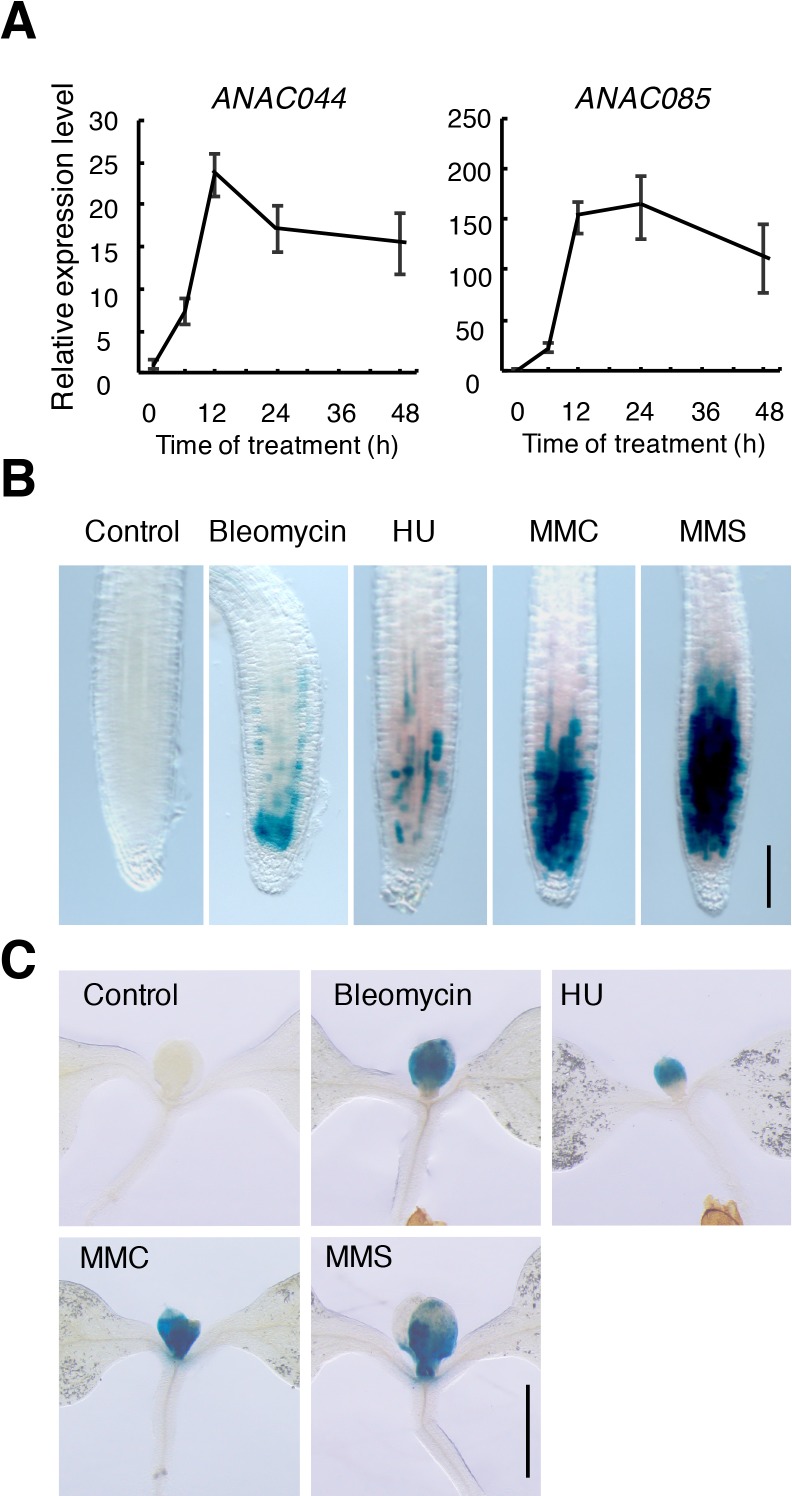
ANAC044 and ANAC085 are induced by DNA damage.(A) Transcript levels of ANAC044 and ANAC085 after bleomycin treatment. Five-day-old WT seedlings were treated with 0.6 µg/ml bleomycin for 0, 6, 12, 24 or 48 hr. The mRNA levels were normalized to that of ACTIN2 and are indicated as relative values, with that for 0 hr set to 1. Data are presented as mean ±SD (n = 3). (B, C) Five-day-old seedlings harbouring ProANAC044:GUS were transferred to medium supplemented with or without 0.6 µg/ml bleomycin, 1.5 mM hydroxyurea (HU), 3.3 µg/ml mitomycin C (MMC) or 80 ppm methyl methanesulfonate (MMS), and grown for 24 hr. GUS-stained seedlings were observed for the root tip (B) and shoot apex (C). Bars = 100 µm (B) and 1 mm (C).10.7554/eLife.43944.005Figure 1—figure supplement 1—source data 1.Source data.